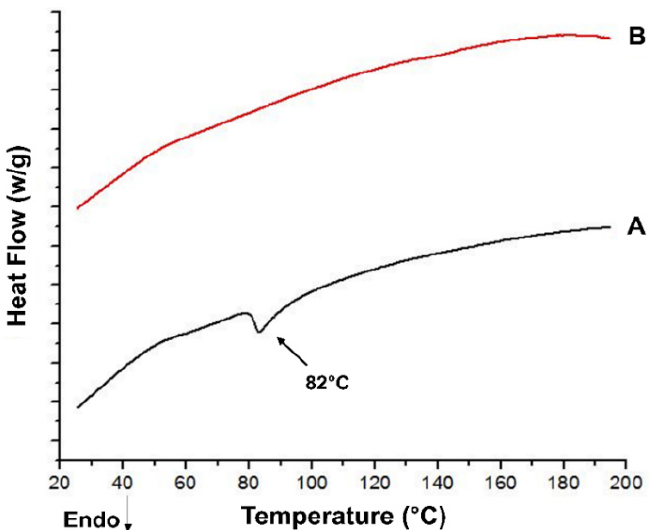
Figure 7. DSC thermograms of ( A ) EBT and ( B ) oral film loaded with optimized transfersomes (ETF-5-TOFs).